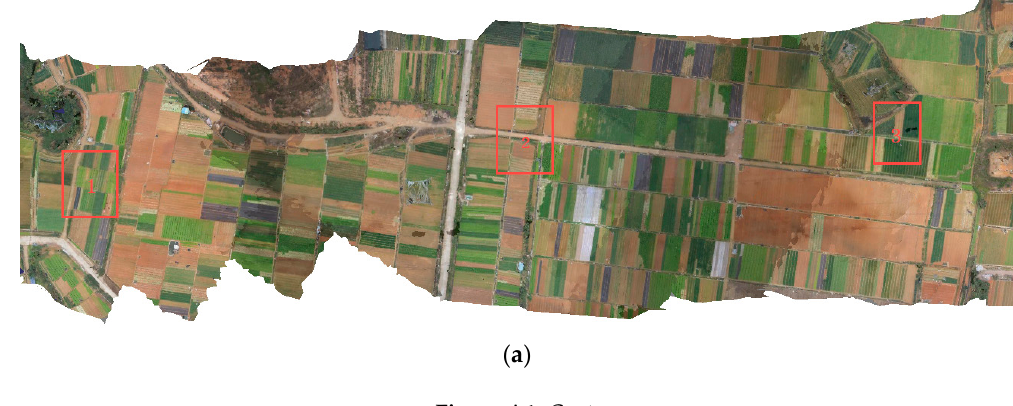
Figure S1: Image orientation and 3D reconstruction of power pylons and lines of some test